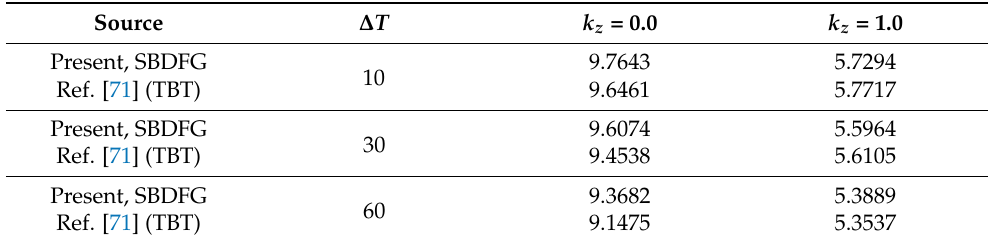
Table 3. Comparison of the fundamental dimensionless frequency of simply supported